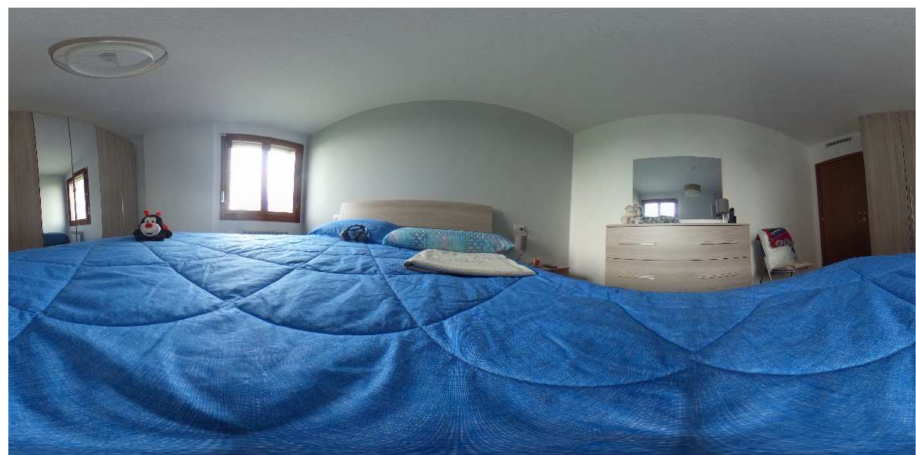
Figure 1. Task 5: 360 ◦ environment that represents the bedroom.